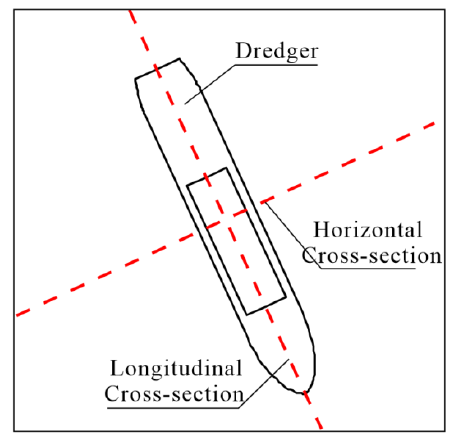
Figure 8. Definition of the two cross ‐ sections.